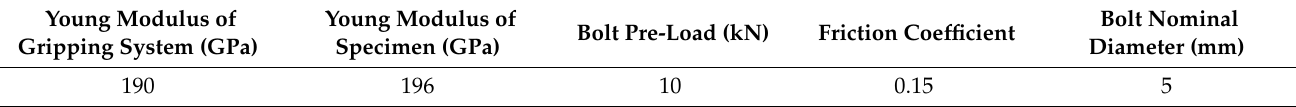
Table 4. Parameters used on the calibrated numerical model.